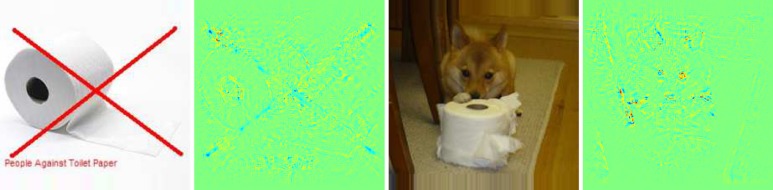
Failure examples for the pixel-wise decomposition.Left and Right: Failures to recognize toilet paper. The decompositions computed by Formula (58) with stabilizers ɛ = 0.01 The neural net is the pre-trained one on ILSVRC data from the Caffe package [60]. The computing methods for each column are the same as in Fig 25. Pictures in order of appearance from Wikimedia Commons by authors Robinhood of the Burger World and Taro the Shiba Inu.